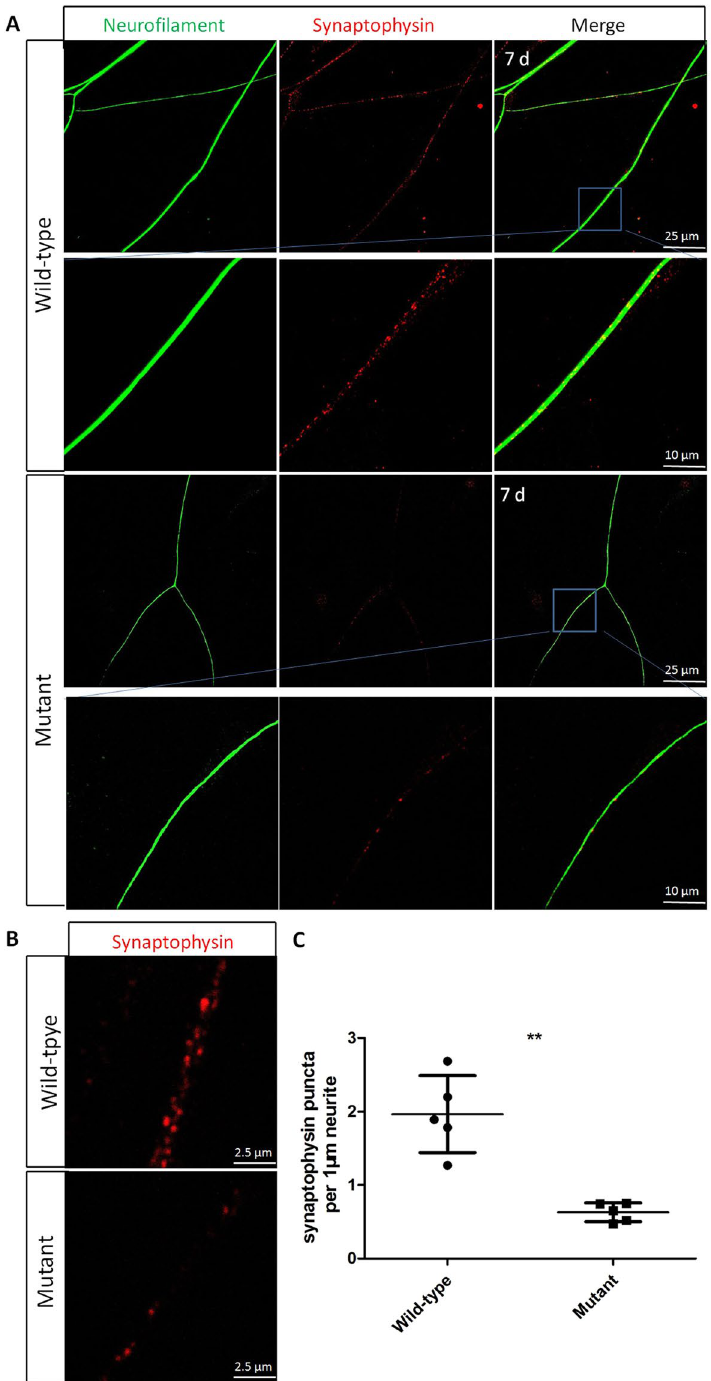
Figure 7. SPAG6 deficiency decreases synapse density in SGN explants ( A ) Representative images of SGNs explants from Spag6 mutant mice and wild-type mice immunostained with neurofilament (green) and synaptophysin (red). ( B ) Representative images in high magnification of synaptophysin (red) immunostained SGN explants from Spag6 mutant mice and wild-type mice. ( C ) Quantification of the number of synapse puncta in the mutant and wild-type SGN explants. (wild-type,1.964 ± 0.5223, N = 5; mutant, 0.6279 ± 0.1279, N = 5; “N” indicates the number of individual experiments ** P < 0.01). Comparisons between two groups were tested by Student’s